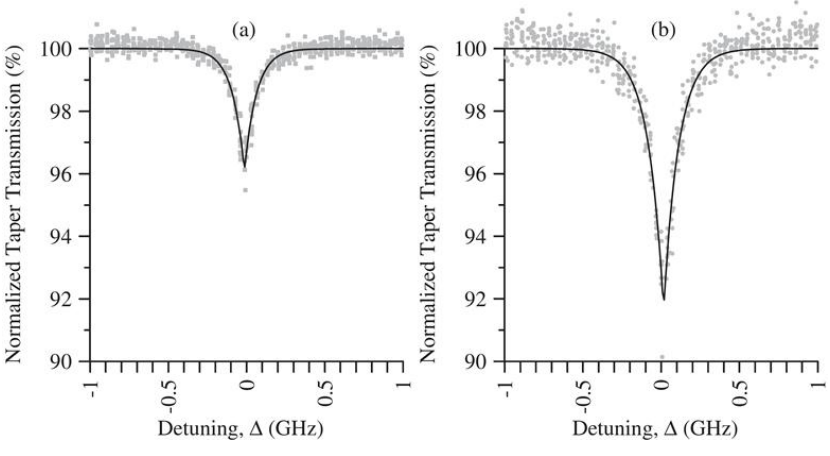
Figure 10. Resonant two-photon absorption in an ONF vapor system for Rb. The percent transmission of the 776 nm signal through the nanofiber is plotted as a function of its detuning from the upper atomic state. ( a ) 780 nm power level of 146 nW. ( b ) 780 nm power level of 726 nW. Reprinted with permission from [79]. Copyright 2010 American Physical